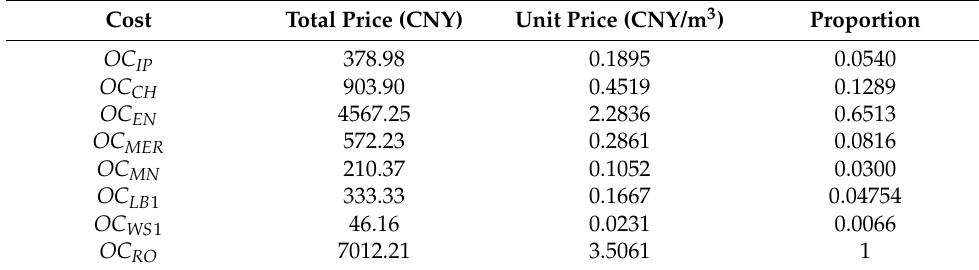
Table 5. SWRO system cost ratio table.